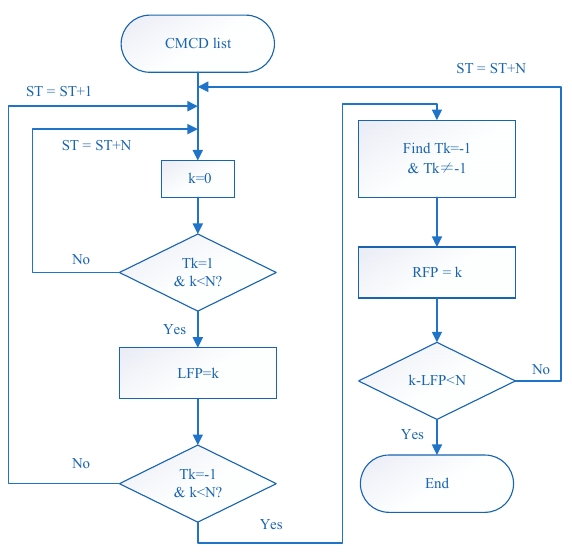
Figure 2. Flowchart of the peak extracting method.